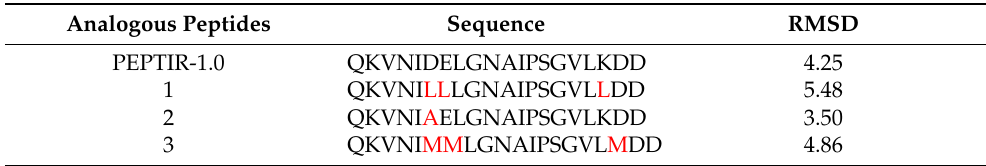
Table 1. RMSD values associated with the three analogous peptides selected. Analogous Peptides Sequence RMSD PEPTIR-1.0